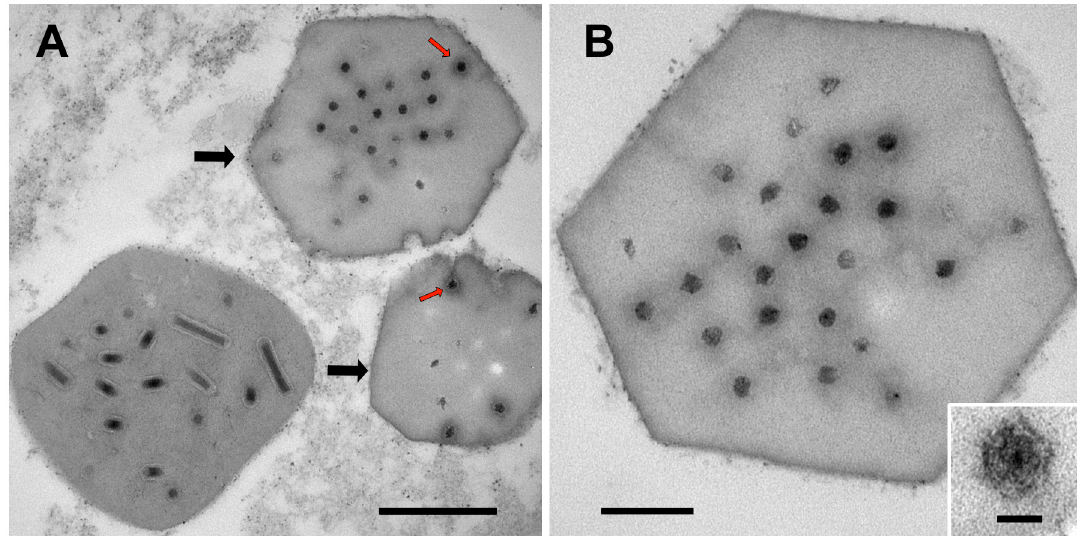
Figure 2. OBs of presumptive cypoviruses found in the OpbuNPV-MA OB preparation. ( A ) OpbuNPV-MA and cypovirus OBs. Black arrows denote two cypovirus OBs adjacent to an OpbuNPV-MA OB, and red arrows point to examples of the virus-like particles in the presumptive cypovirus OBs. ( B ) Higher magnification image of a presumptive cypovirus OB, with an inset showing a high magnification image of one of the occluded virus-like particles. Scale bars: ( A ) 500 nm; ( B ) 200 nm; ( inset ) 40 nm.